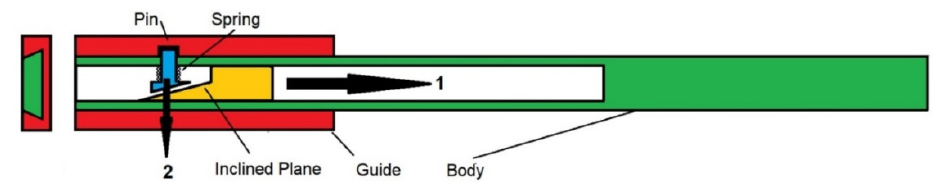
Figure 1. Conceptual design of the plate dynamization system.